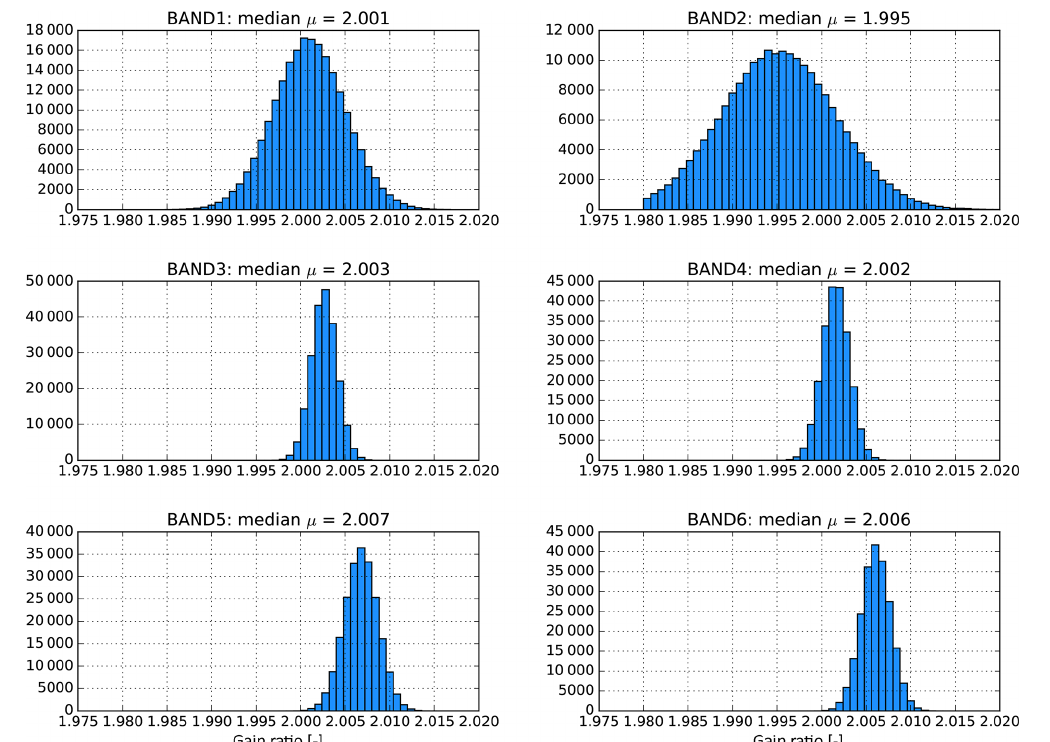
Figure 9. The histogram of the obtained pixel gain ratios for PGA gain = 2 and reference settings otherwise, for all UVN